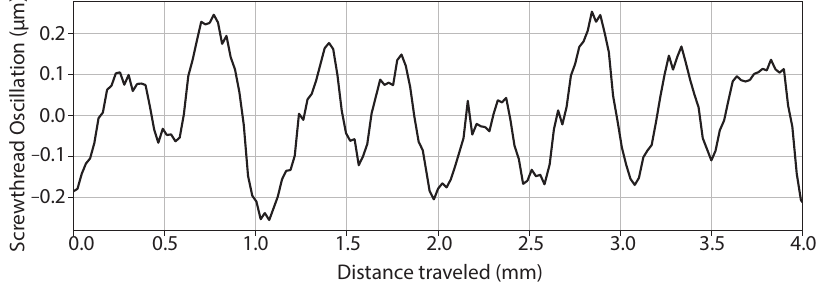
Figure 2. Screwthread pitch measured by in-house LCI system for x-axis motion. The measurement procedure involved laterally translating the step at 0.1 mms − 1 past the sensing head with continuous capture of singular spectra across 4 mm. Due to the 125 Hz operating speed of the spectrometer, this gave a transverse datapoint density of 8 µ m. After each lateral scan, the x-axis stage was homed and the sample translated away from the fibre tip by 6.19 µ m until the sensor reading was approximately the same as